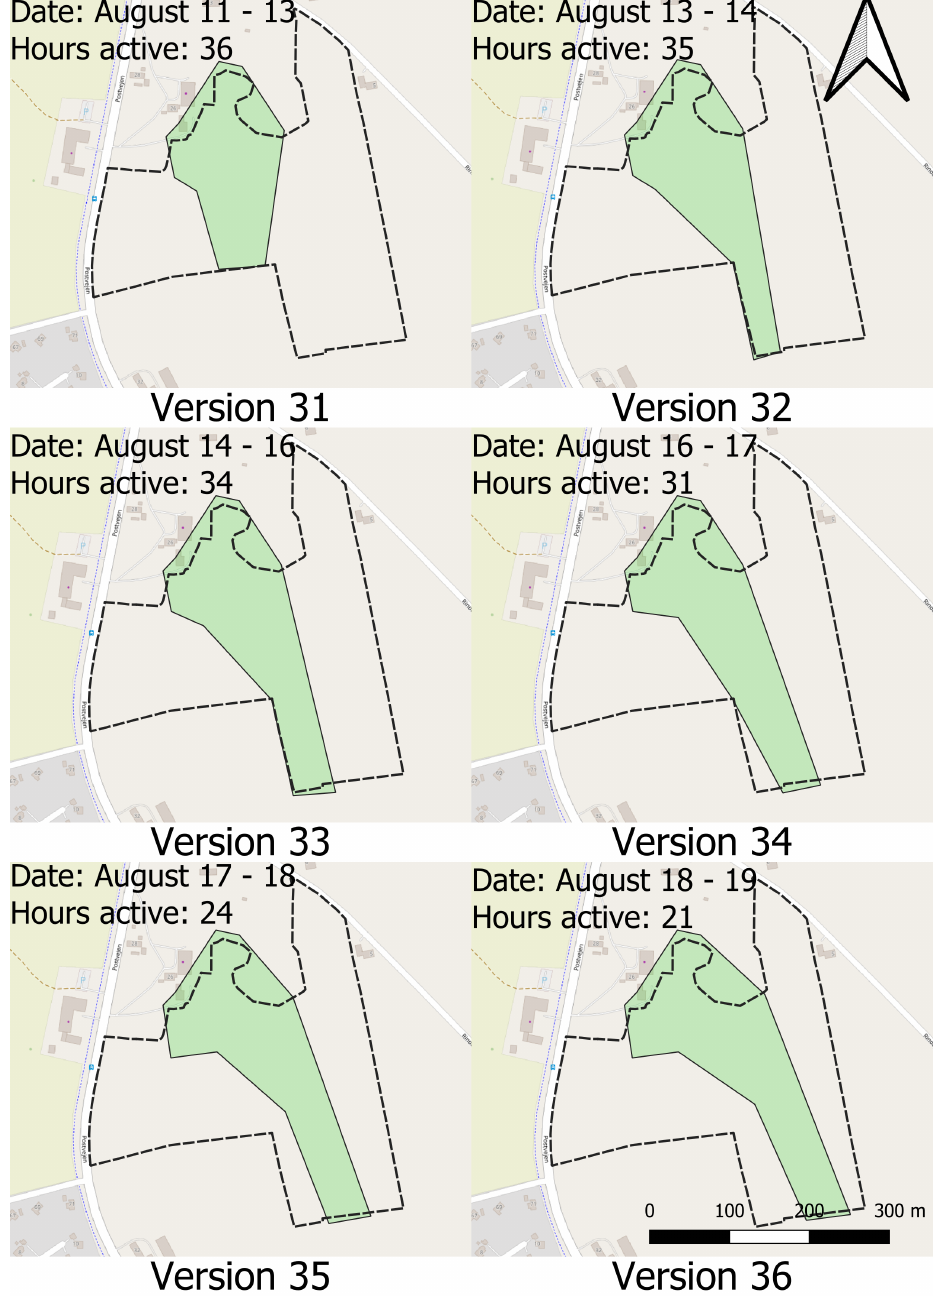
Figure A6. Virtual enclosure version 6 dating from 11 August to 19 August. The dashed black line represents the physical fence surrounding the 8.2 ha grazing area. The marked green area represents the virtual enclosure. Only virtual enclosures active for more than 12 h were included. The coordinates of the upper left corner of the map frame are 55°25 (cid:48) 23.131 (cid:48)(cid:48) E 8°23 (cid:48) 53.531 (cid:48)(cid:48) N. Map data from OpenStreetMaps